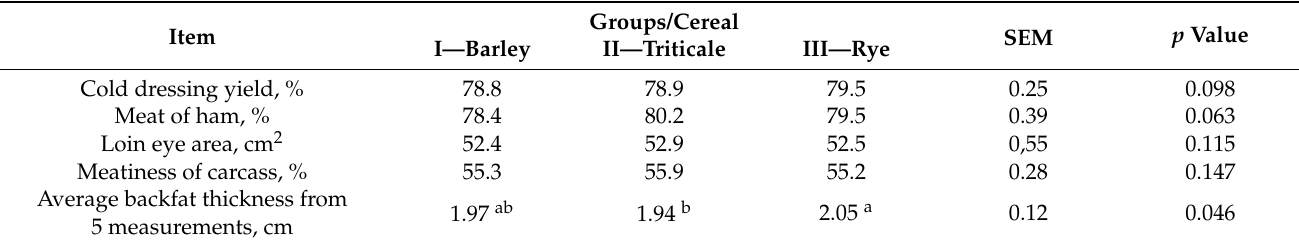
Table 5. Carcass quality traits of fattened